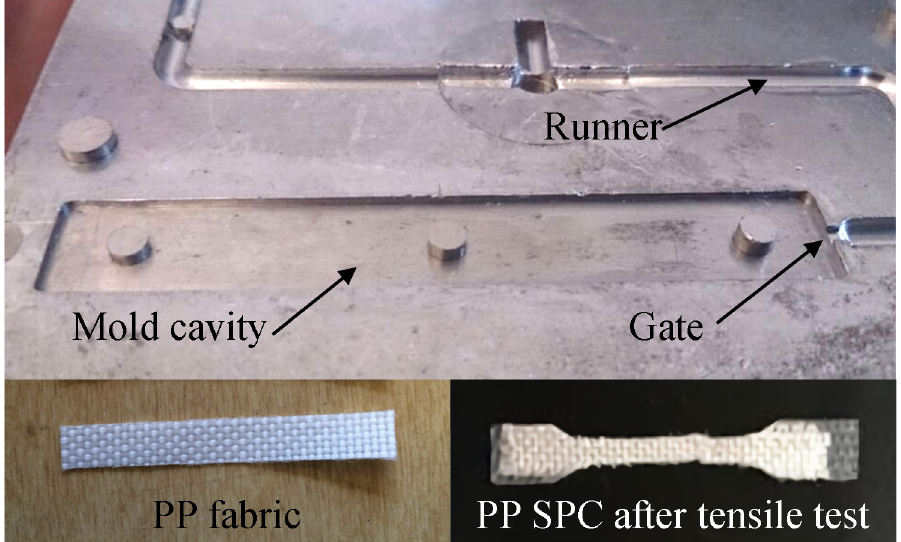
Figure 2. Pictures of the mold plate, PP fabric, and the PP SPC after tensile test.